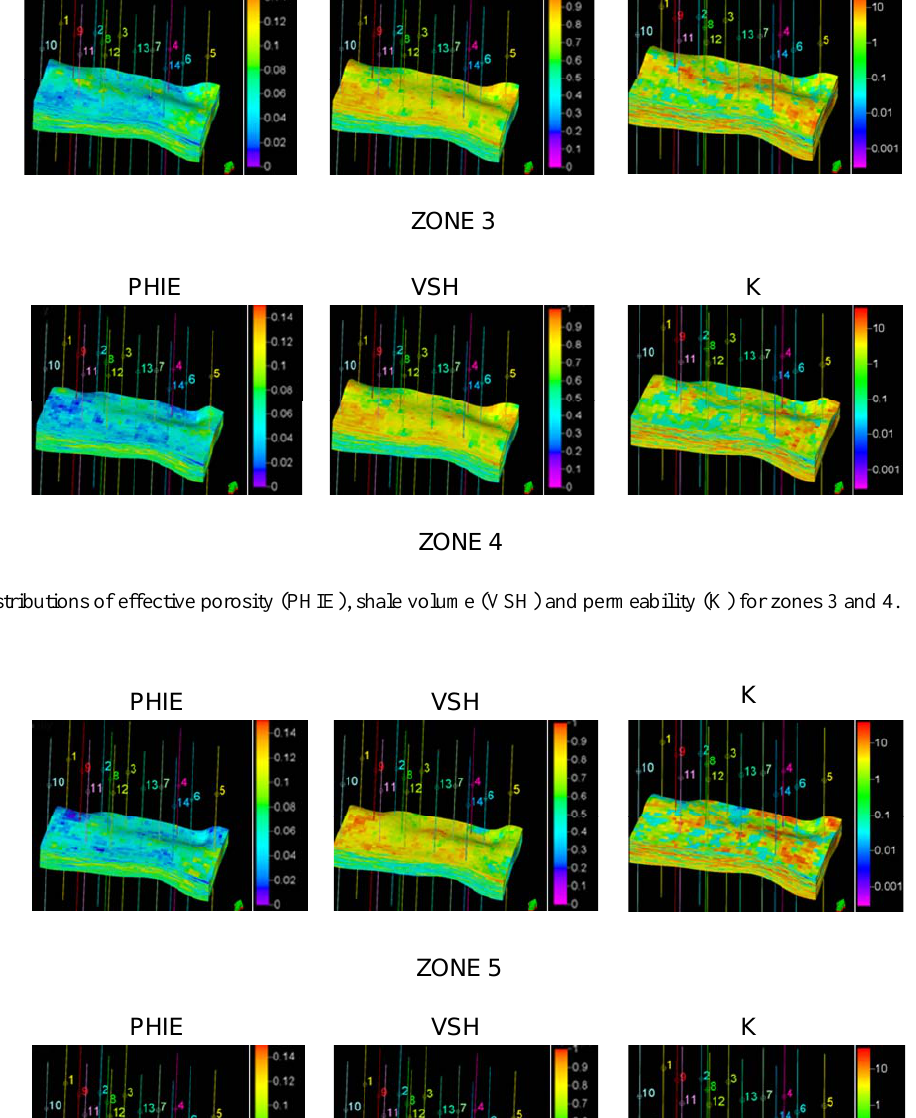
Fig. 7. Fractal distributions of effective porosity (PHIE), shale volume (VSH) and permeability (K) for zones 1 and 2.